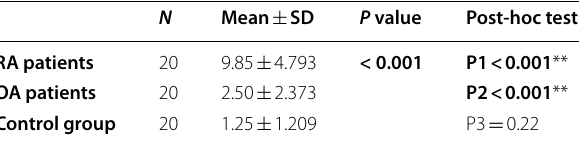
mean Athens Insomnia Scale